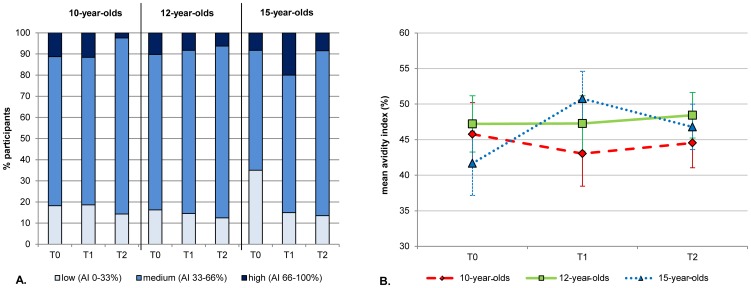
Meningococcal Serogroup C Polysaccharide Specific Immunoglobulin G (IgG) Avidity Indices (AI).Avidity indices divided in low, intermediate and high (a) and mean avidity indices (b) per age group prior to (T0) and 1 month (T1) and 1 year (T2) after the MenC conjugate booster. Only serum samples from participants with an IgG concentration of ≥0.25 µg/ml at T0 were included in the analyses (44 10-year-olds, 49 12-year-olds and 60 15-year-olds). Serum samples were diluted to a concentration of 25 ng/ml. Avidity index  =  (amount of IgG still bound after treatment with 0.5 M NH4SCN/amount of IgG with PBS) x 100.